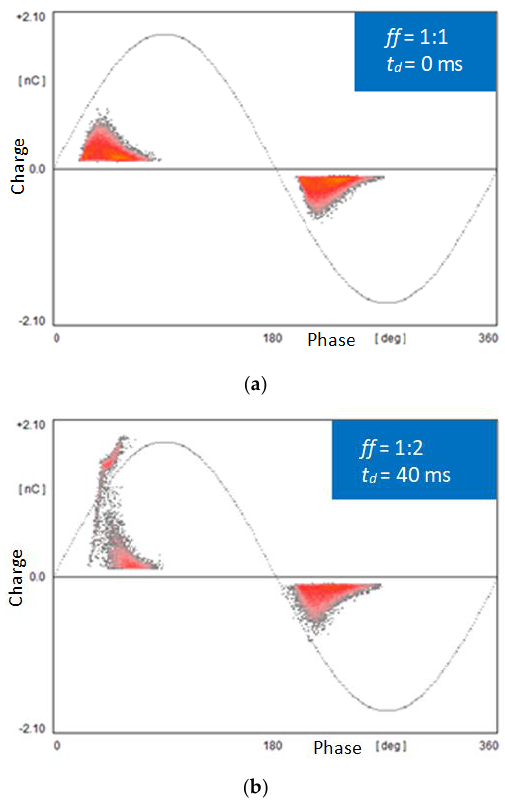
Figure 5. PD pattern obtained at ( a ) continuous sinusoidal voltage ( t d = 0 ms), at 7.5 kV, in void, embedded in a thermosetting material, and in the chopped PD sequence; ( b ) 1:2; ( t d = 40